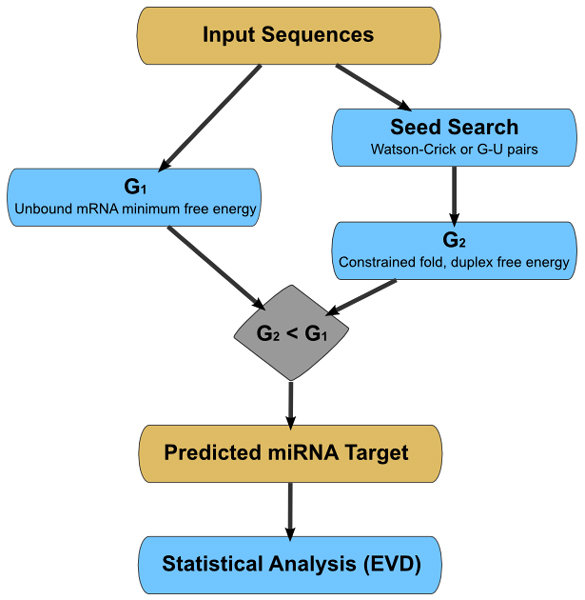
MicroTar algorithm. Beginning with a set of fasta-formatted query (miRNA) sequences and target (mRNA) sequences, the MicroTar algorithm predicts the minimum free energy of the each mRNA molecule, searches for seed sites, and performs a constrained fold where each seed match is, in turn, bound in the miRNA-mRNA heterodimer; the output is a list of putative duplexes more stable than free mRNA, along with images of bound and unbound mRNA secondary structure. This result is subsequently subjected to a statistical analysis to determine the significance of each miRNA-mRNA match.